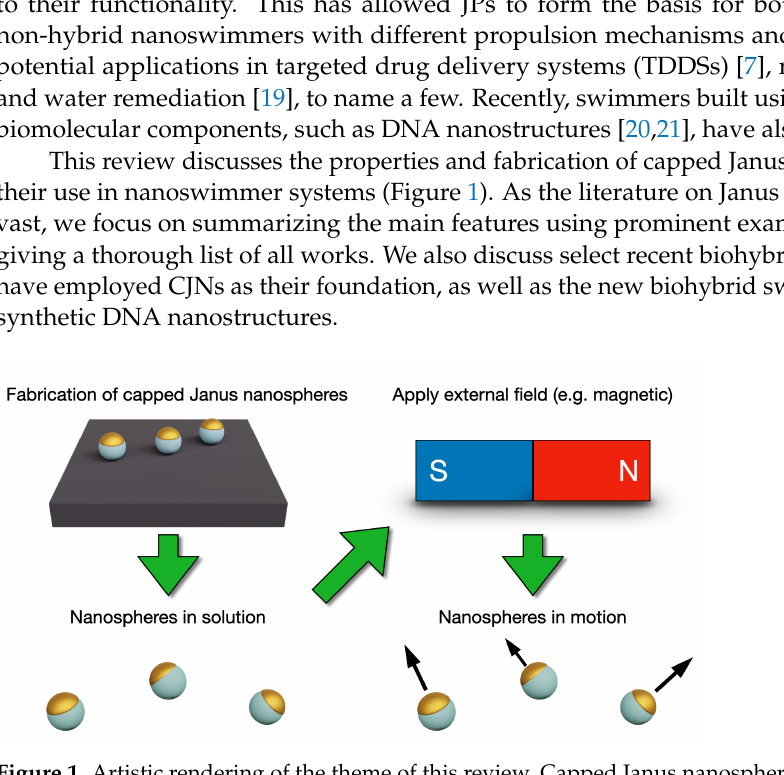
Figure 1. Artistic rendering of the theme of this review. Capped Janus nanospheres can be fabricated, for example, on a supporting substrate and further resuspended in solution. Upon the introduction of a chosen external field or fuel, the nanospheres elicit a directional